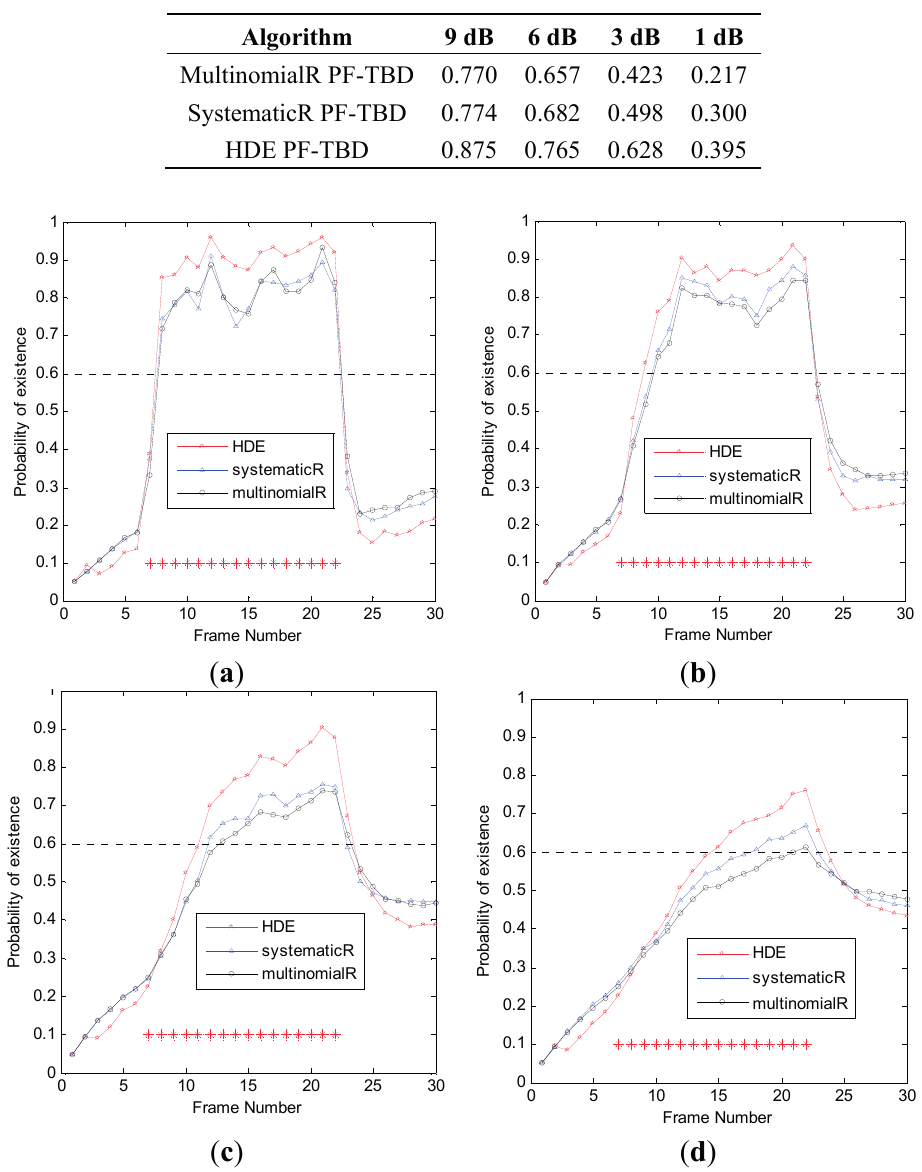
Figure 2. ( a ) Probability of the existence at SNR = 9 dB for the CV model; ( b ) probability of existence at SNR= 6 dB for the CV model; ( c ) probability of existence at SNR = 3 dB for the CV model; ( d ) probability of existence at SNR = 1 dB for the CV